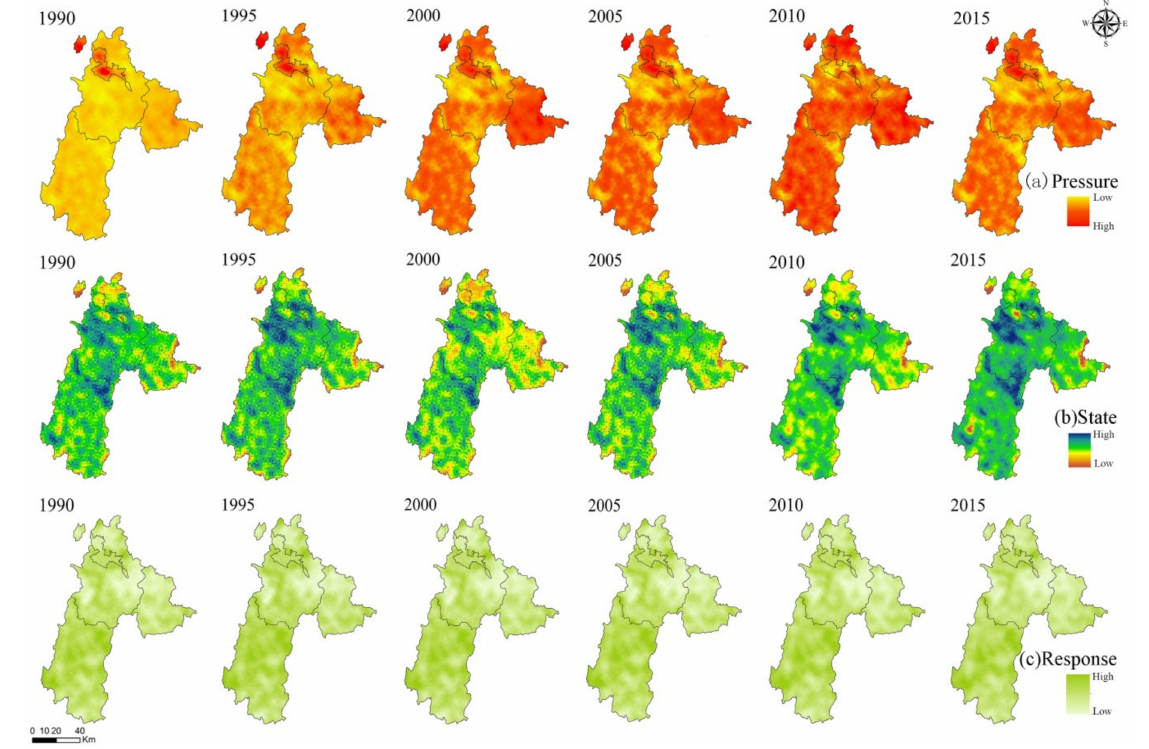
Figure 3. Temporal and spatial distribution of each index layer from 1990 to 2015: ( a ) Pressure; ( b ) State; ( c ) Response. (According to each color band, we can know the changing trend of the value of different index